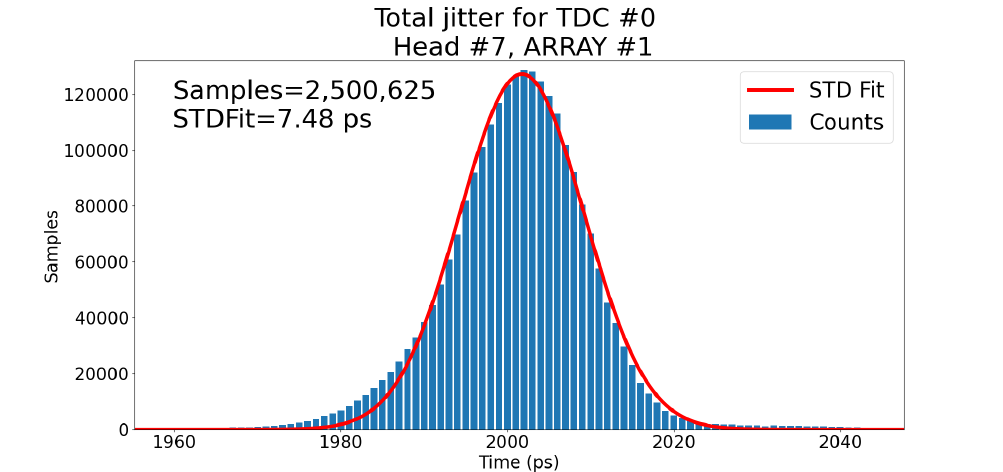
Figure 13. Total jitter of the TDC #0 of head #7 with all TDCs active for all codes. Sweep the clock- correlated start signal from 0 to 4000 ps with 1 ps steps, centered and aligned at 2000 ps. This result is the sum of all 4001 measurements and aligned. Even though the distribution is not Gaussian, the red line is a Gaussian fit to the whole distribution to obtain an estimate of 7.48 ps RMS for the jitter.